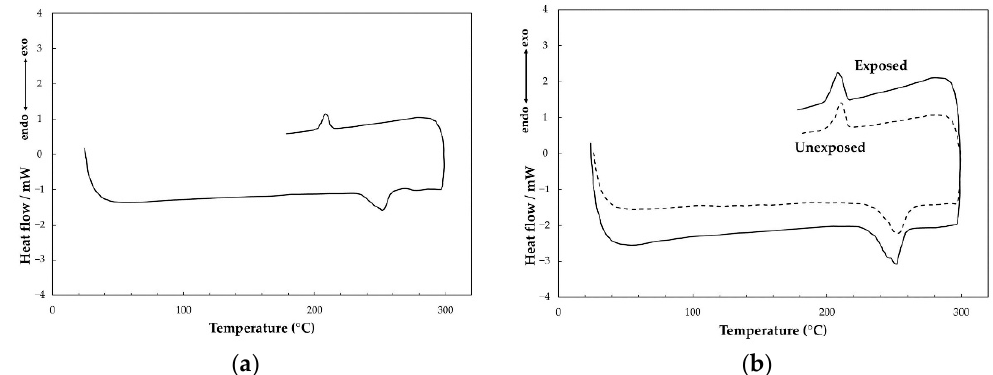
Figure 8. Differential Scanning Calorimetry (DSC) curves for: ( a ) unexposed sample of PC1 section and ( b ) exposed and unexposed samples of VG1 section in nitrogen gas purge, with mass samples around 5 mg. The analyses were conducted with heating rates of 10 °C min − 1 with a flow of 50 mL min − 1 in the aluminum crucible.